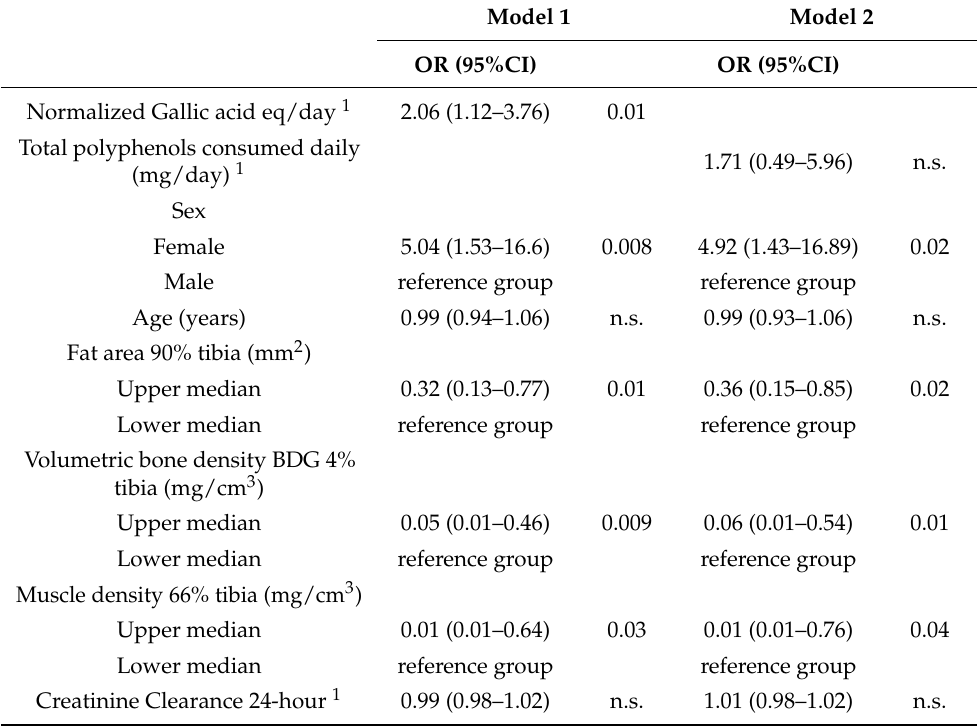
Table 3. Logistic regression analysis, factors predicting fracture risk. Urinary gallic acid was cubic- root normalized; total polyphenols consumed was natural-logarithm transformed. Fat area at 90% tibia length, volumetric bone density BDG at 4% tibia length, and muscle density at 66% tibia length were contrasted in the analysis according to median level of